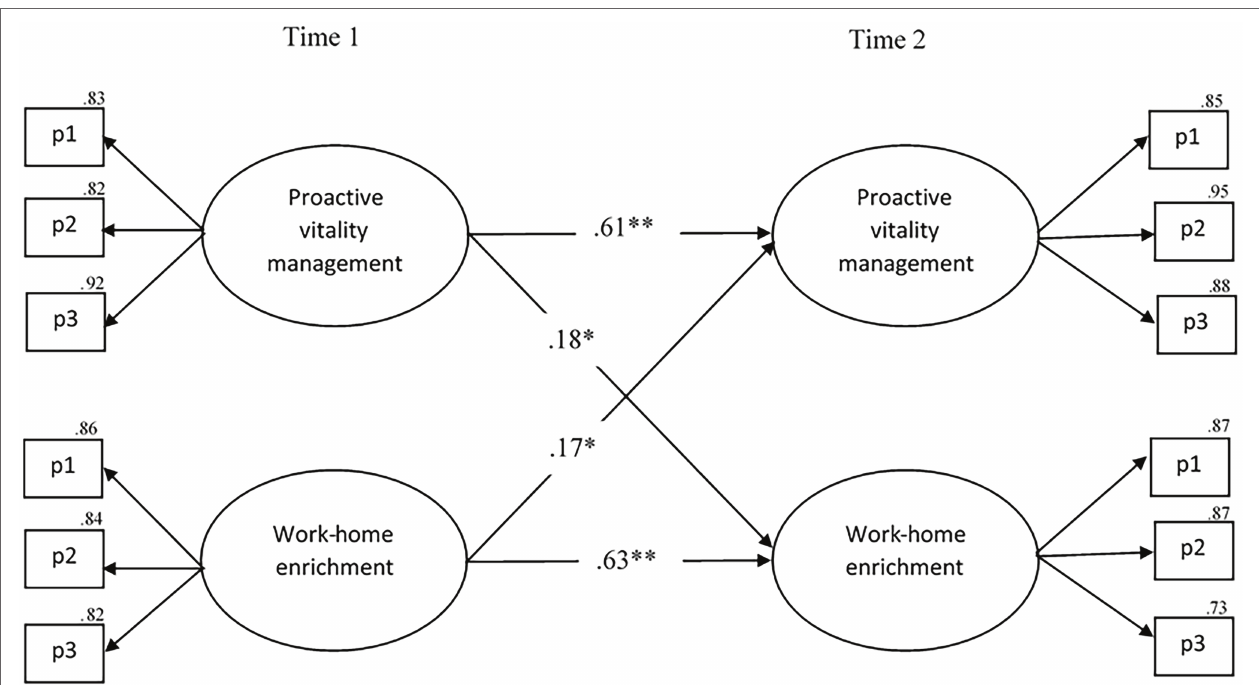
FIGURE 3 | The final model of the statistically significant cross-lagged relationships between proactive vitality management and work–home enrichment. N = 249,